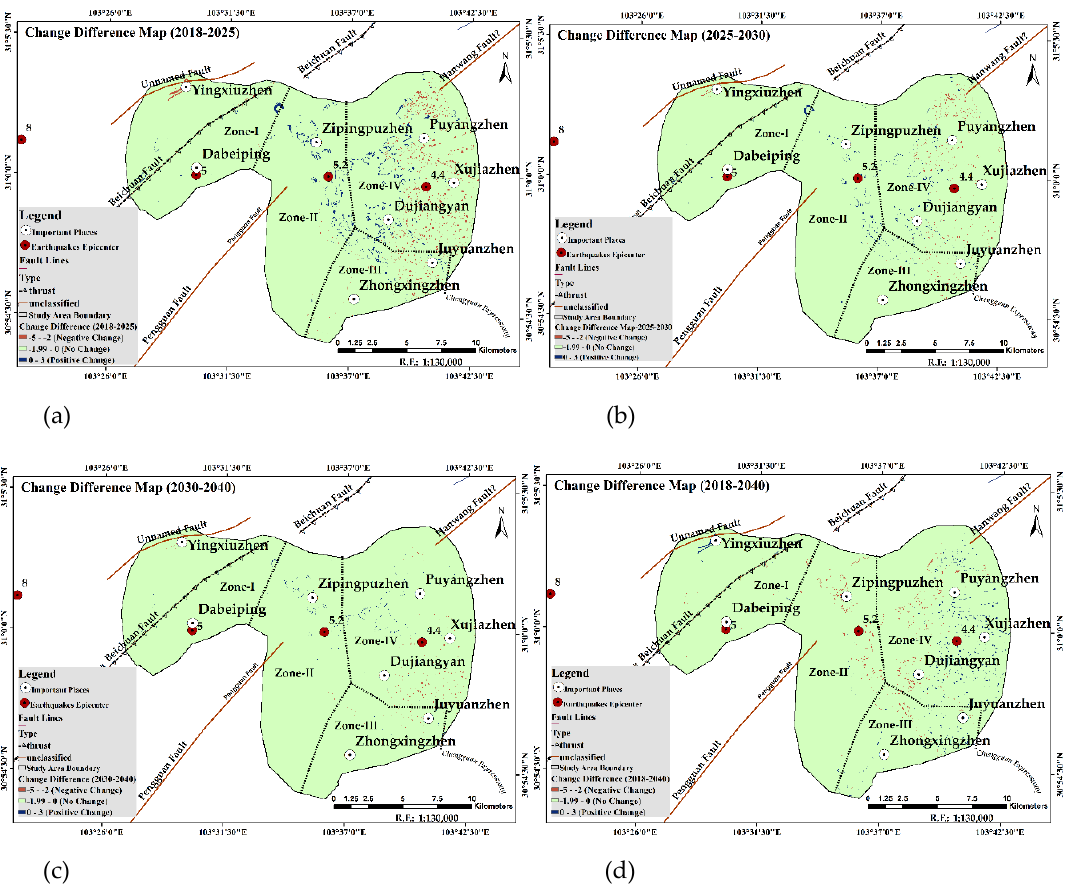
Figure 7. Change difference map of the study area based on the projected LULC maps of 2018, 2025, Figure 7. Change di ff erence map of the study area based on the projected LULC maps of 2018, 2025, 2030, and 2040; (a) change difference map for the periods 2018-2025; (b) change difference map for 2030, and 2040; ( a ) change di ff erence map for the periods 2018–2025; ( b ) change di ff erence map for 2025-2030; (c) change difference for 2030-2040; and (d) overall change difference between 2018 and 2025–2030; ( c ) change di ff erence for 2030–2040; and ( d ) overall change di ff erence between 2018 and 2040.